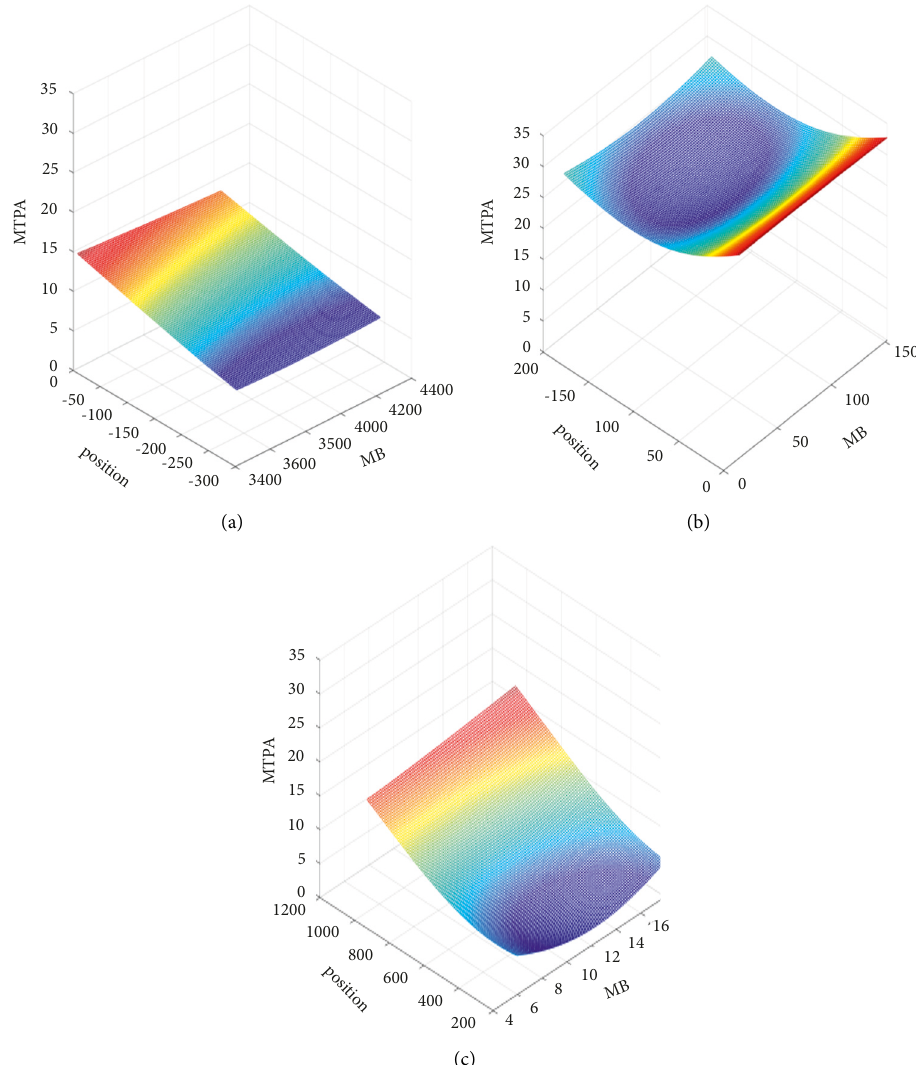
Figure 11: The effect of measured brightness and position on MTPA in stages 1–3. (a) Stage 1. (b) Stage 2. (c) Stage